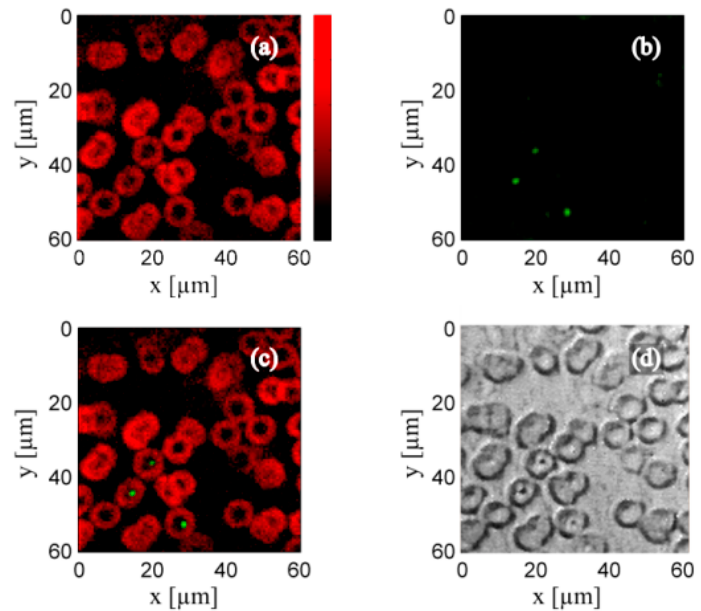
Figure 17. ( a ) OR-PAM image ( a ) and simultaneously obtained luminescence image ( b ) of human red blood cells. ( c ) Overlay of the PA and luminescence image. ( d ) Bright-field image of the same region. Reproduced with permission from Ref. [97].